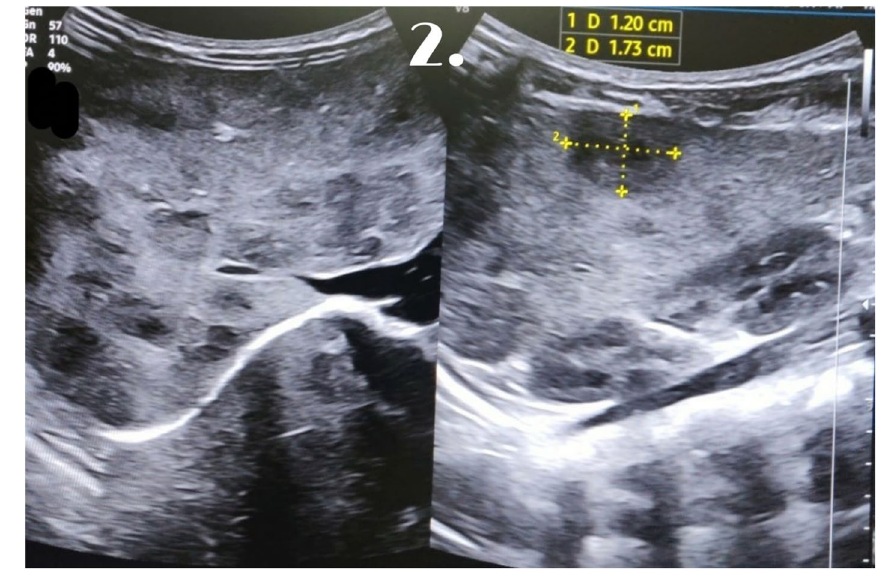
Fig. 2 Ultrasound abdomen image of index case after